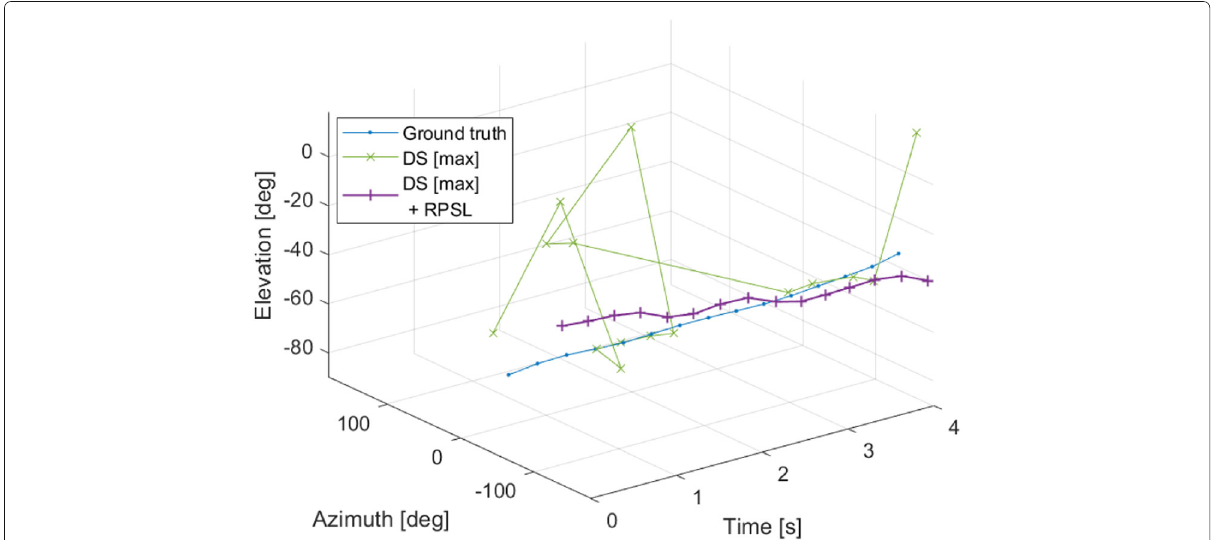
Fig. 15 Example of localisation path estimated for flying UAV speech sound source (task 3) case 2 [1], using the baseline and proposed method (RPSL only)